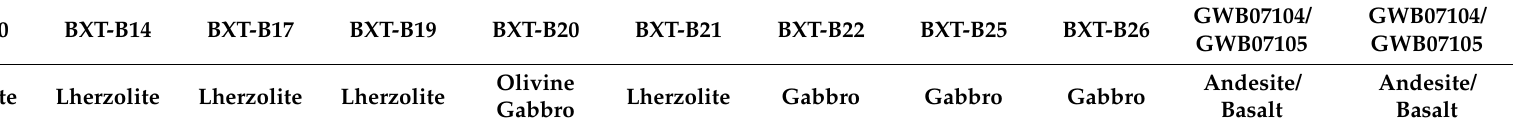
Table A2. Major (wt. %) and trace element ( × 10 − 6 ) analyses of the Baixintan